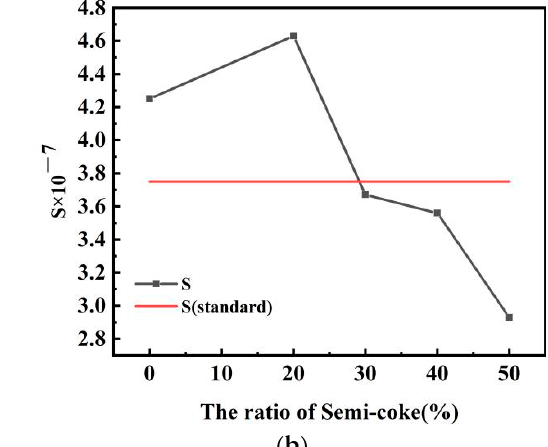
Figure 5. Variation of combustion characteristic parameters of semicoke and bituminous coal after adding catalyst. Figure 5 shows that, with the addition of 2 wt % Fe 2 O 3 to semicoke, the ignition tem- perature and maximal combustion-rate temperature of semicoke both decreased by 0.79% and 1.7%, respectively, and the burnout temperature of semicoke increased by 0.17%. In contrast, when 2 wt % Fe 2 O 3 was added to the bituminous coal, its ignition temperature was basically unchanged, its maximal combustion-rate temperature decreased by 1.4%, and its burnout temperature decreased by 2.9%. Figure 5 also shows that the maximal weight-loss rate of semicoke decreased by 4.6%, and the comprehensive combustion char- acteristic index increased by 6.2%; and the maximal combustion rate and comprehensive combustion characteristic index of bituminous coal increased by 7.5% and 35.38%, respec- tively. Comparing the different catalytic effects of catalysts on bituminous coal and semi- coke showed that the addition of 2 wt % Fe 2 O 3 had a greater effect on the early stages of the combustion phase of semicoke, and a greater effect on the middle and late stages of the combustion phase of bituminous coal. Fe 2 O 3 mainly plays a role in transferring oxygen during the reaction. The same conclusion was obtained from their mechanistic diagrams [35,36]. As temperature gradually increased, a reducing atmosphere appeared around the pulverized coal that oxidized Fe 2 O 3 into FeO [35], making the oxygen content around the pulverized coal more adequate and promoting the reaction. The level of volatile matter directly controls the pyrolysis process of pulverized coal [37]. The low volatile content of semicoke makes the pulverized coal less likely to catch fire. The results of Yao et al. showed that the ignition temperature of semicoke was higher than that of bituminous coal